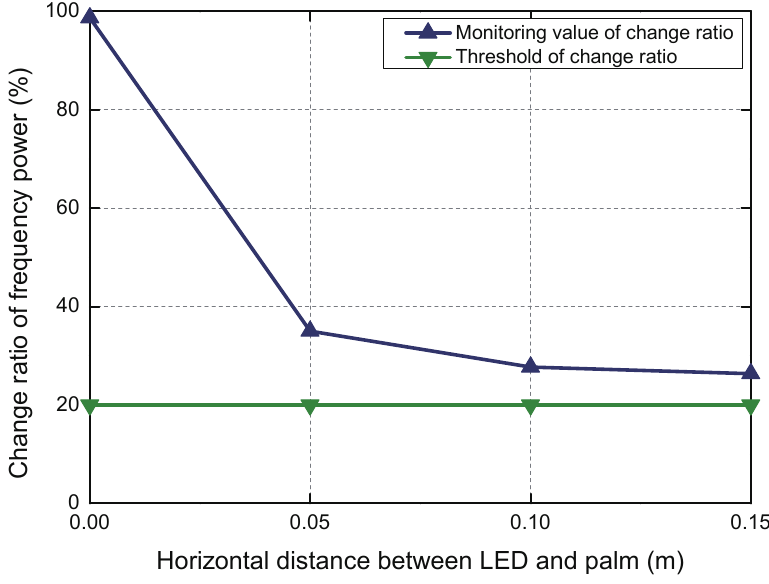
Figure 16. Different sensing areas of